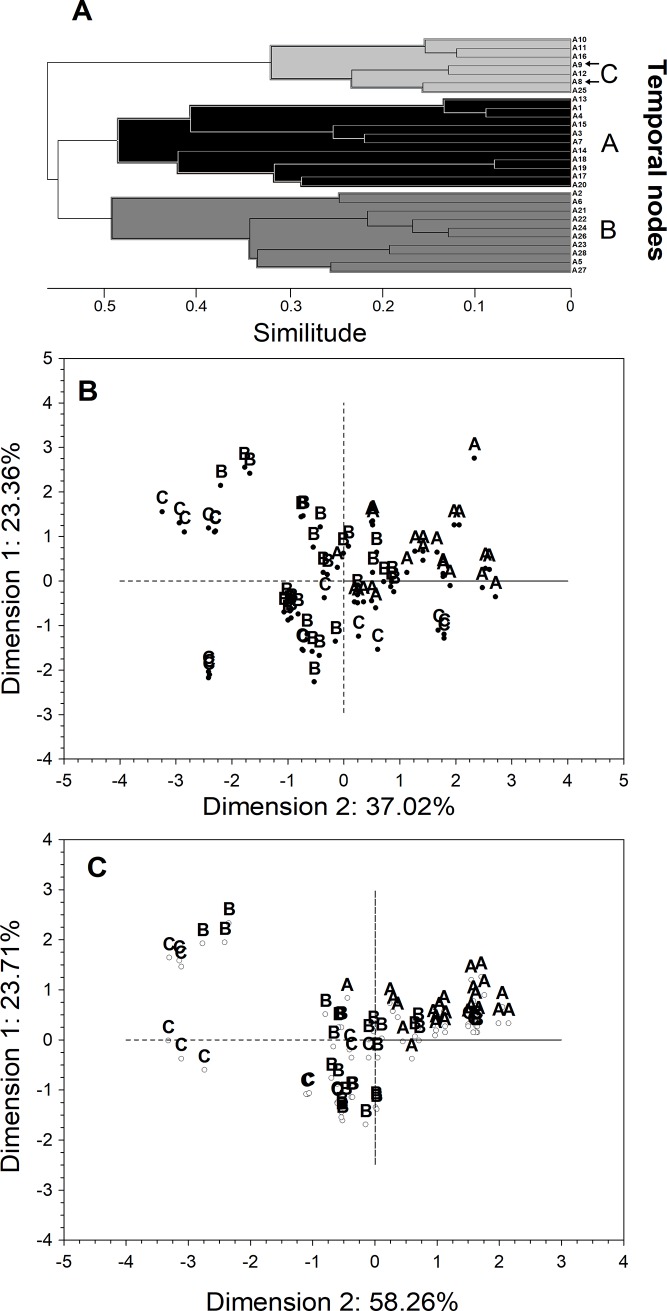
Three main nodes captured much of the observed abiotic and biotic temporal variability.Black arrows in hierarchical clustering (A) denote extremely warms days, which, if excluded from the MDS test (B), increased total explained variance by the temporal partitioning (C).